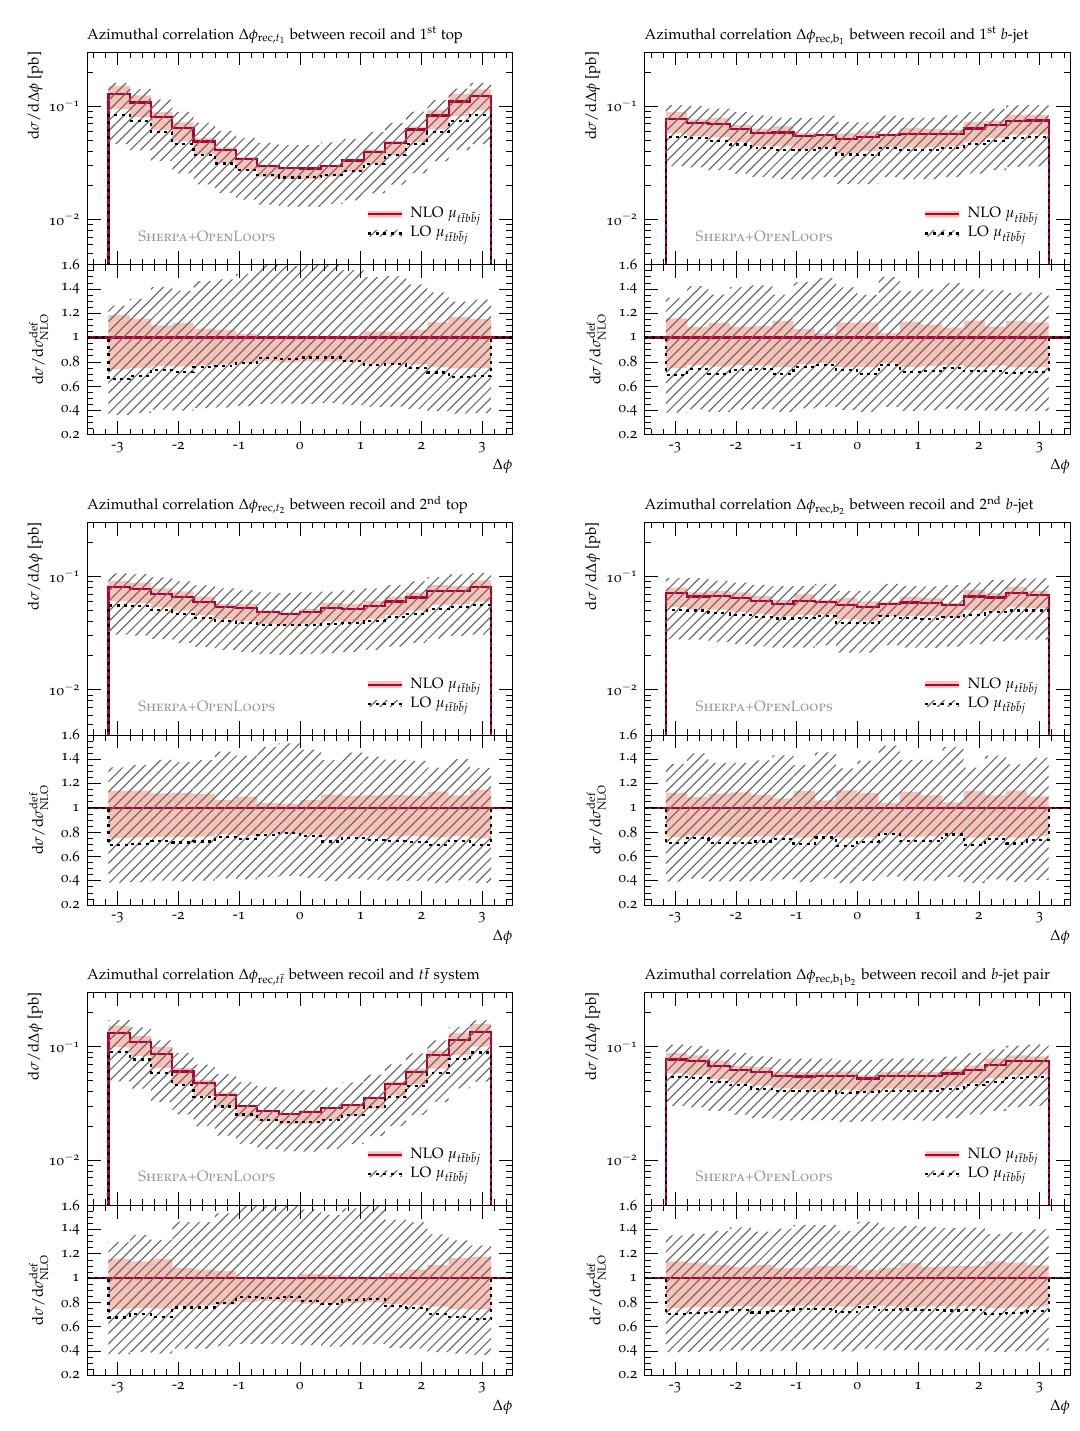
Figure 18. Distributions in the azimuthal angular separation (cid:1) (cid:30) rec ;X between individual objects X of the t (cid:22) tb (cid:22) b system and its recoil. See (5.7){(5.8). The left column shows the angular correlations between the recoil and the top-quark objects X = t 1 ; t 2 ; t 1 t 2 , where t 1 t 2 denotes the top-pair system. Corresponding observables for b -jet objects, X = b 1 ; b 2 ; b 1 b 2 , are shown in the right column. Same setup and plots as in (cid:12)gure